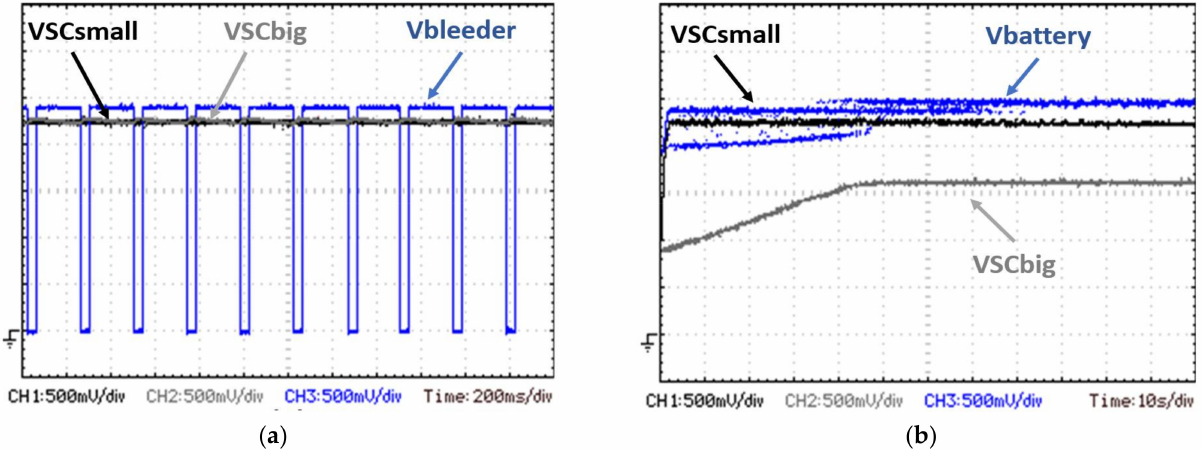
Figure 11. ( a ) SCsmall voltage (CH1), SCbig voltage (CH2) and bleeder output (CH3) during bleeder mode activation. ( b ) SCsmall voltage (CH1), SCbig voltage (CH2) and battery input (CH3) during battery energy